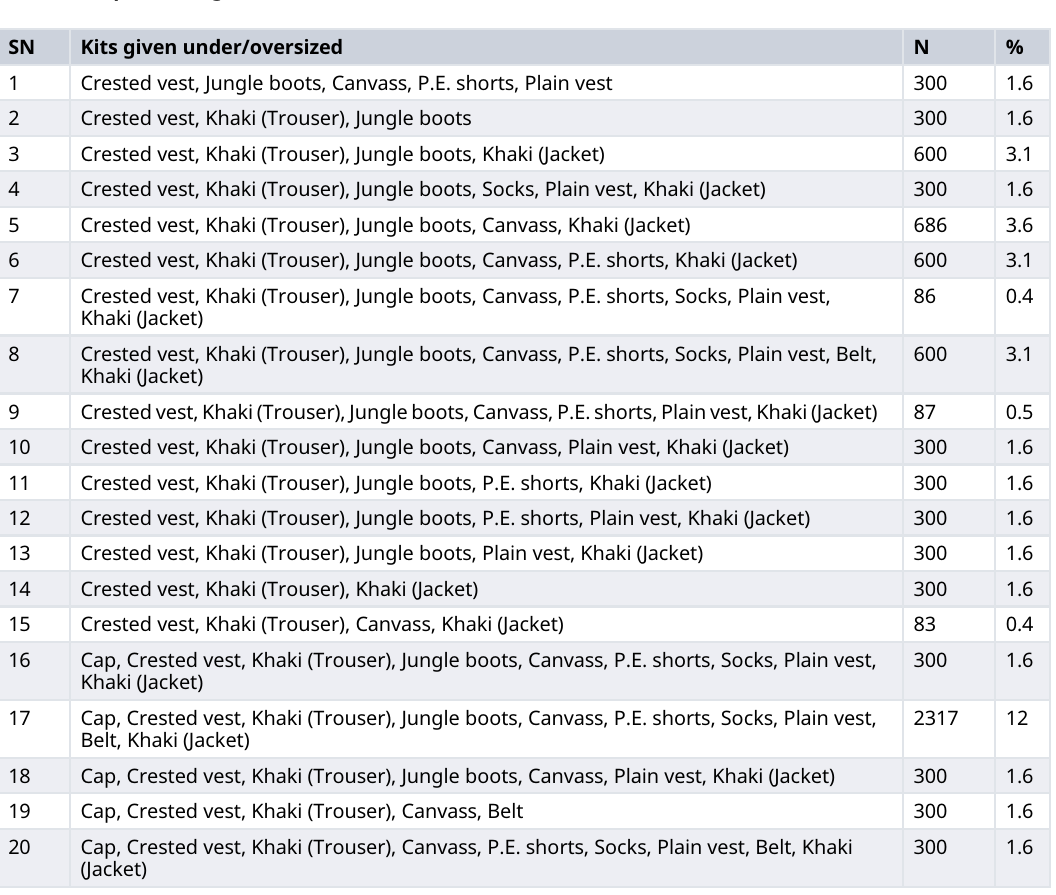
Table 6. Respondents given different combinations of under/oversized NYSC